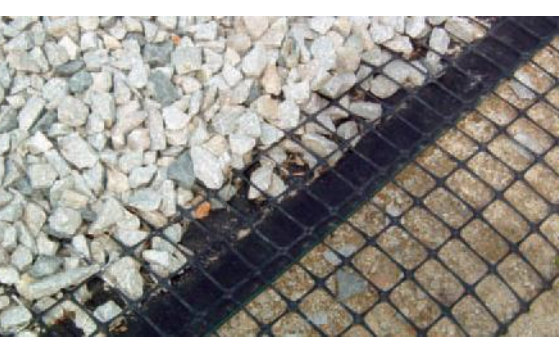
Figure 1. Reinforced geogrid Tensar SS.